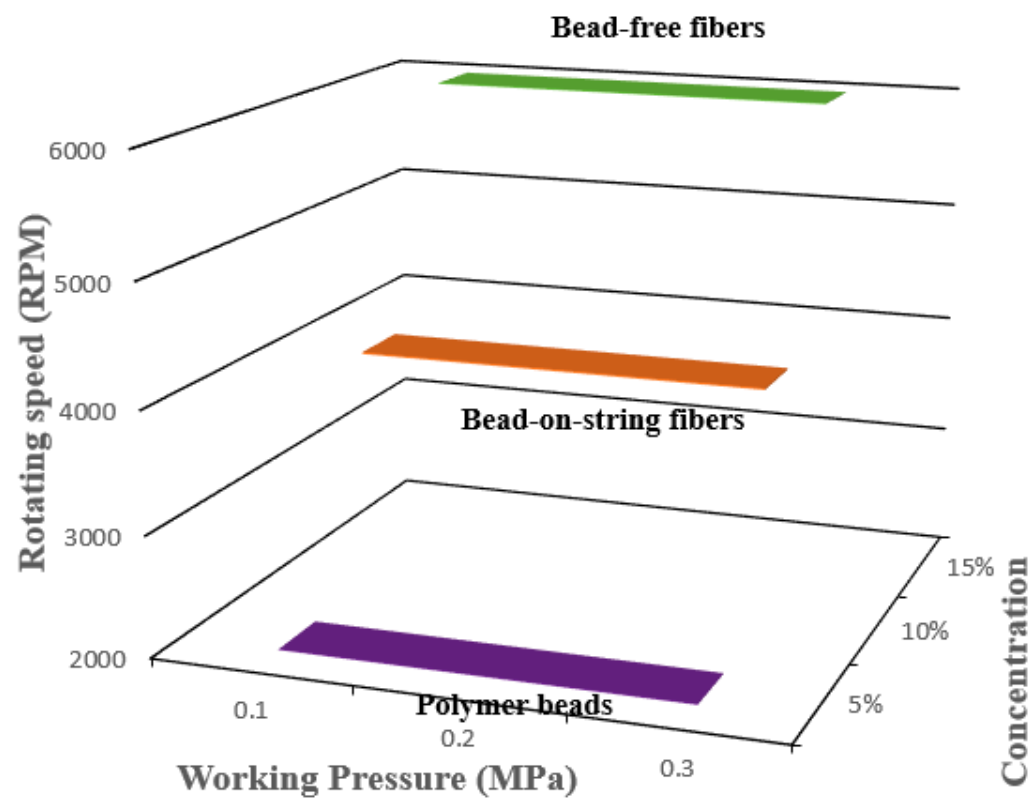
Figure 2. Product mapping as a function of forming parameters.